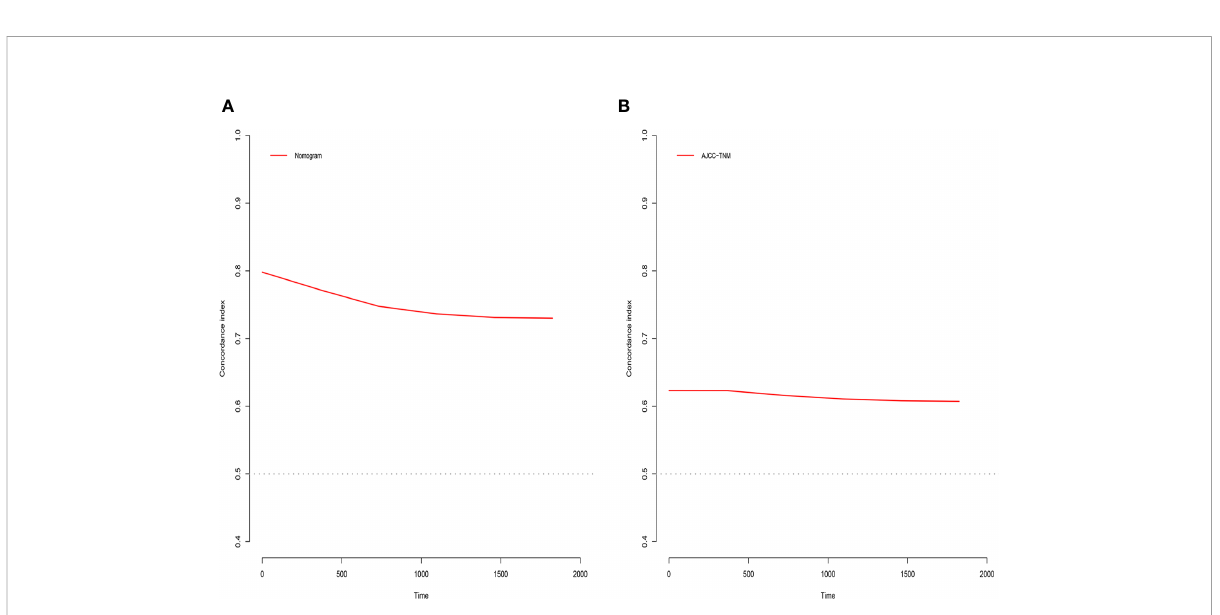
FIGURE 6 C-index analysis. (A) Nomogram-related C-index. (B) AJCC staging criteria-related